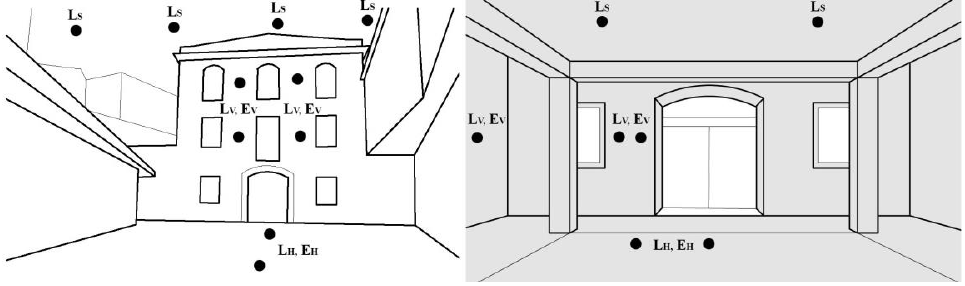
Figure 7. Position of measurement points in Case E.2.